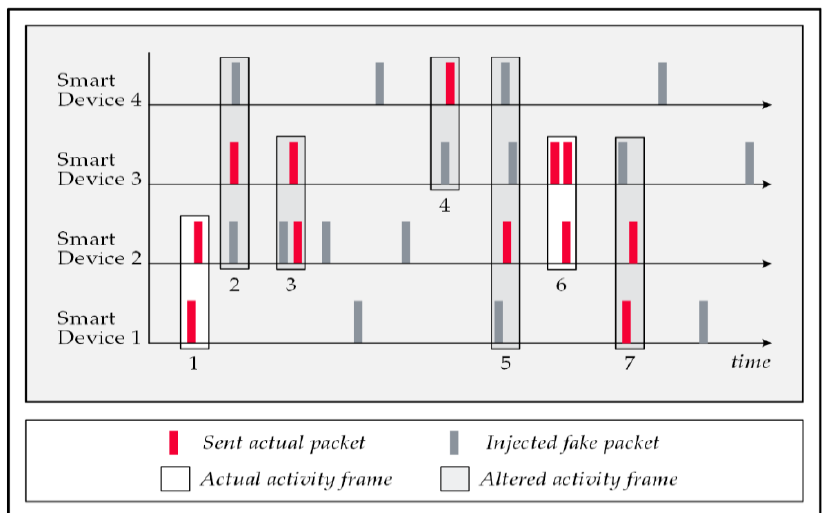
Figure 8. Fake data packet injections.